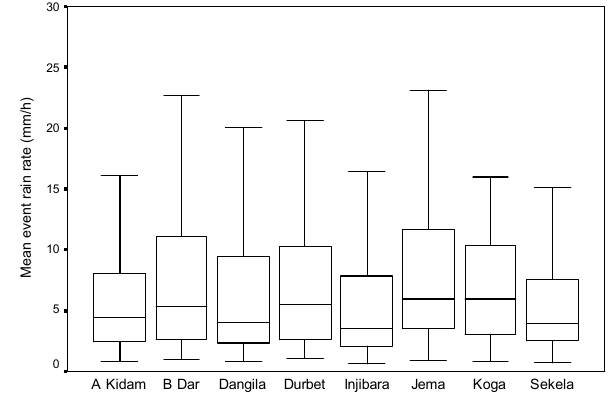
Fig. 3. Box-whisker plot of the rain event durations in JJA of 2007 Fig. 3 Box-whisker plot of the rain event durations in JJA of 2007 as observed at eight 744 as observed at eight rain gauge stations. rain gauge stations. 745 746